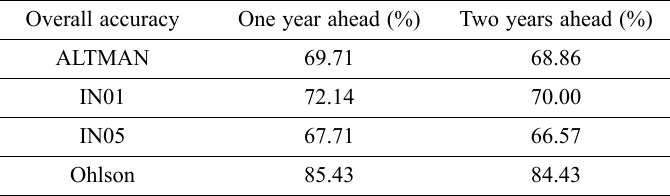
Table 2. Overall accuracy of validated